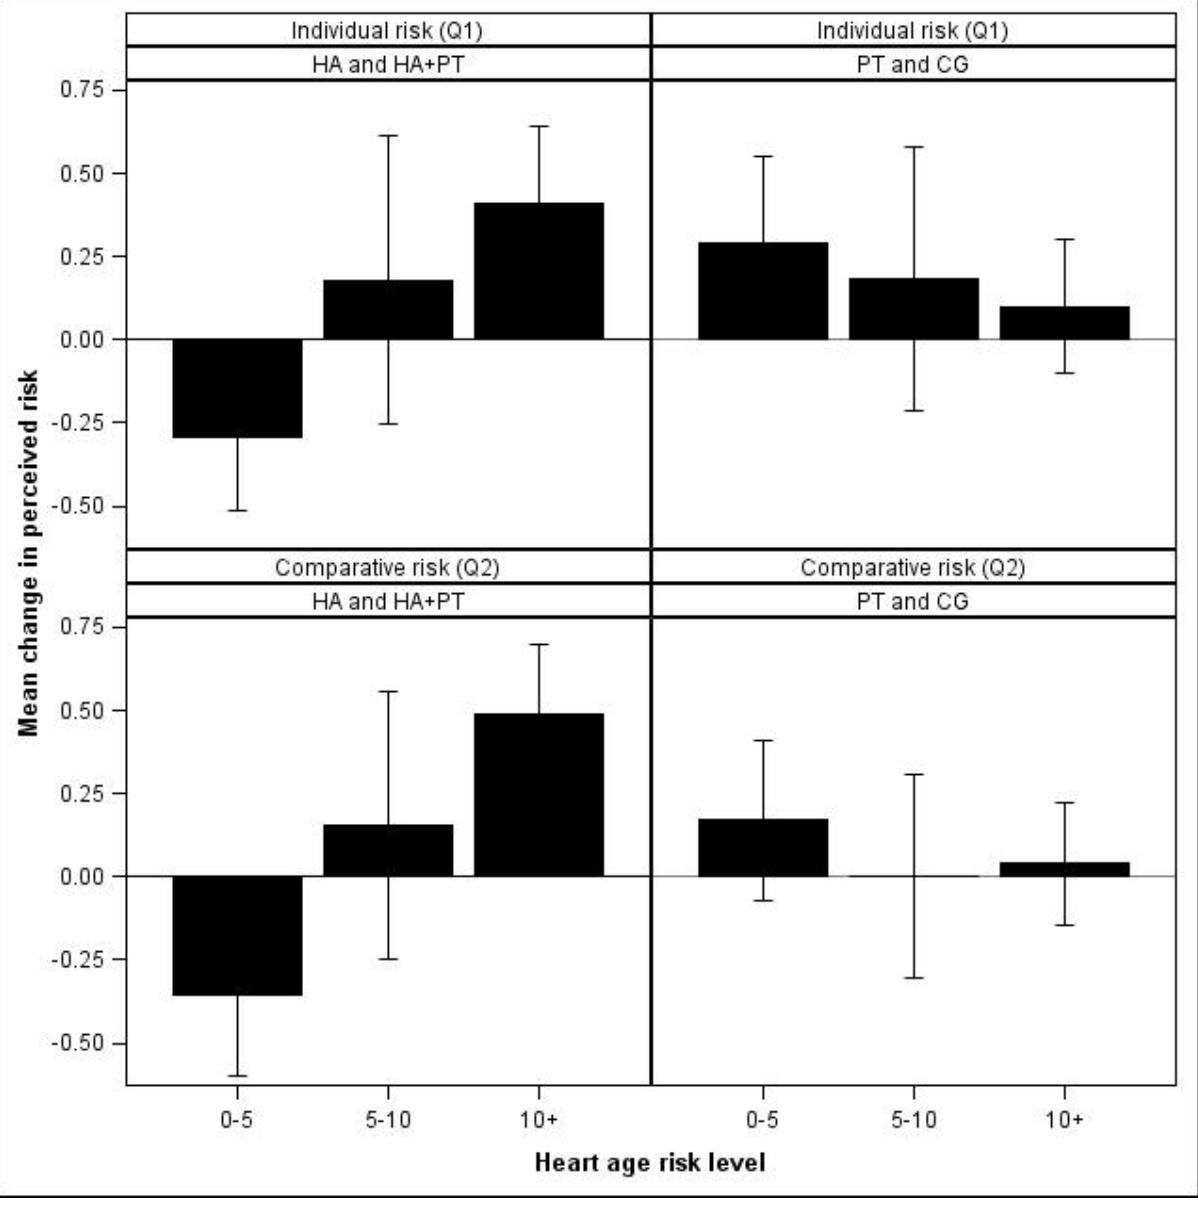
Figure 4. Change in risk perceptions for Q1 and 2 split by Heart-Age